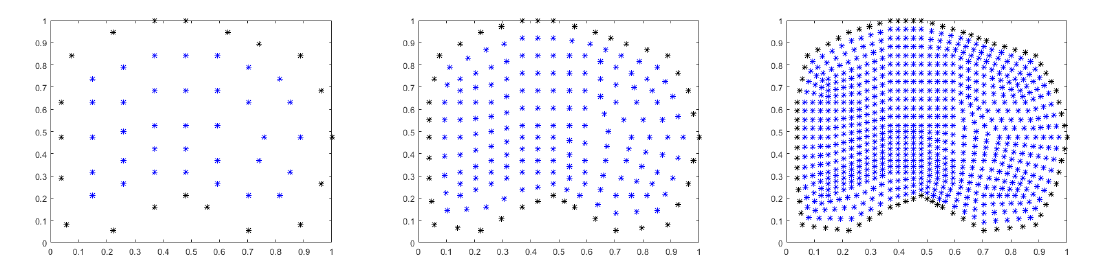
Figure 1. Irregular clouds of points with 55, 197 and 743 nodes